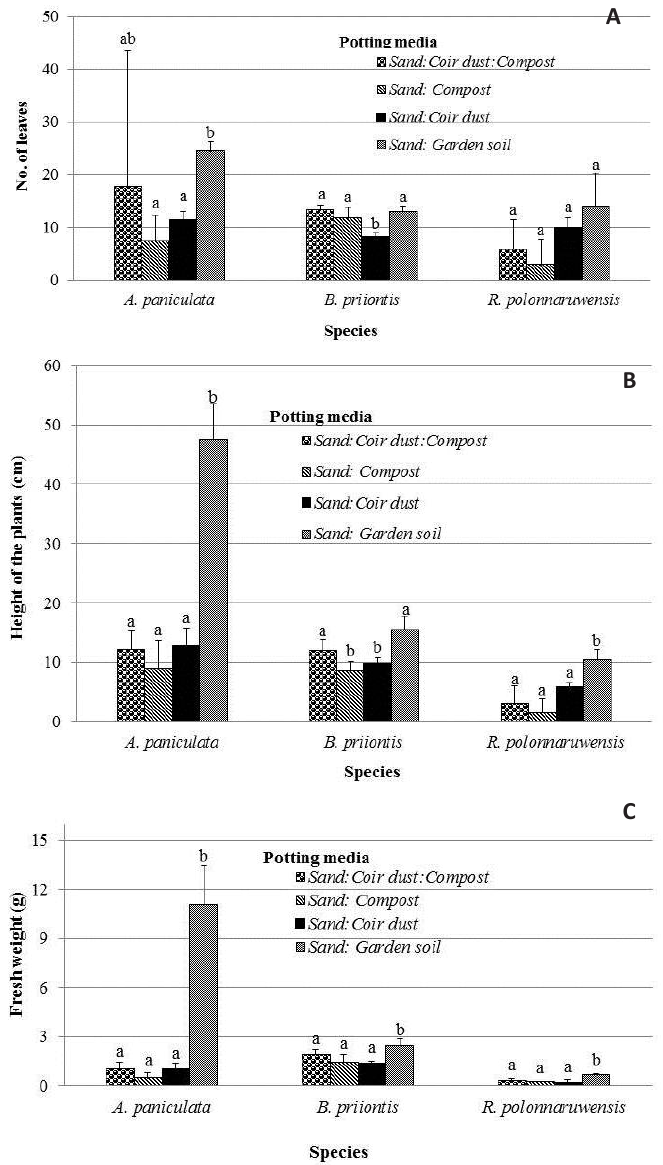
Figure 3: Number of leaves (A), height (B), and fresh weight (C) of A. paniculata var. paniculata, B. prionitis and R. polonnaruwensis seedlings grown in different potting media for 30 days. One-way ANOVA and Moods median test, error bars + SD, n = 10. Different lowercase letters indicate significant differences among treatments within the same species (P < media (Figure 3B). The height of the seedlings in the sand: Shoot height garden soil medium was significantly different from that of The same trend as for number of leaves was observed the plants grown in other media. The height of B. prionitis with plants heights. The tallest A. paniculata (F = 103.2, seedlings grown in the sand: garden soil and sand: coir P < 0.001) and R. polonnaruwensis (F = 82.7, P< 0.001) seedlings were observed in the sand: garden soil potting